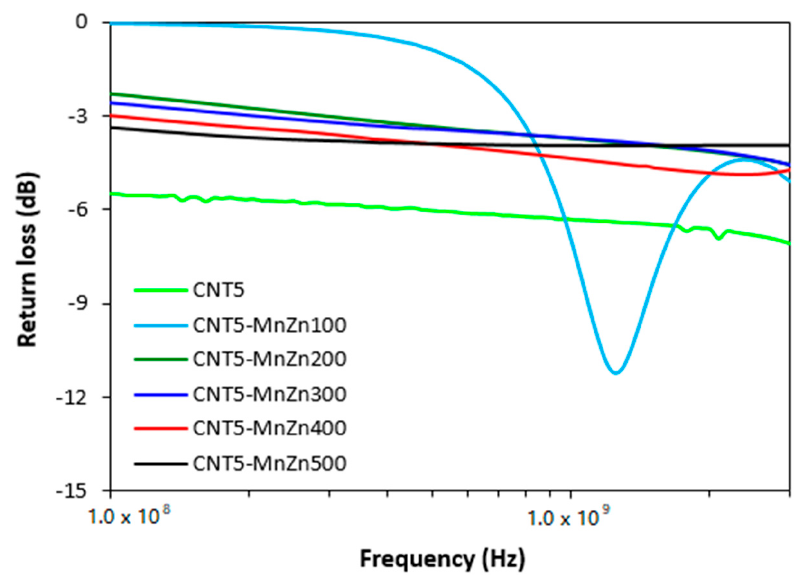
Figure 9. Frequency dependences of return loss for hybrid CNT/ferrite filled composites.